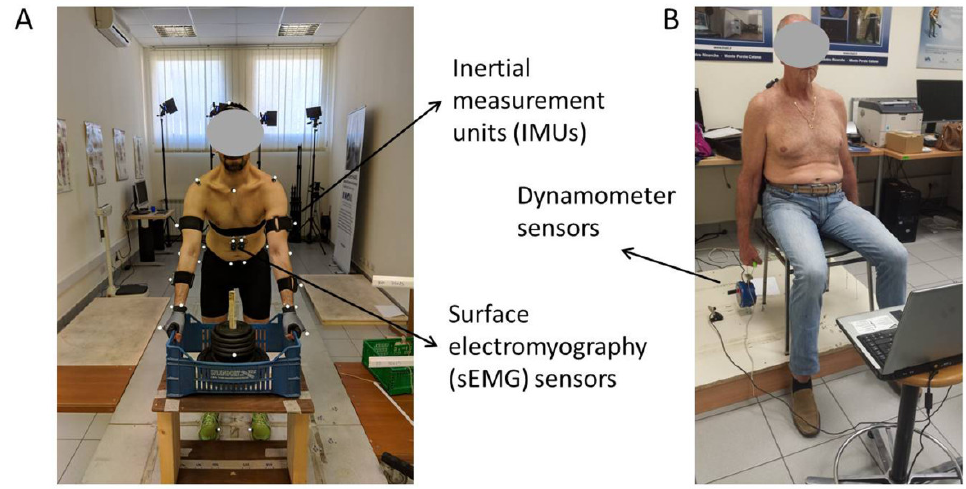
Figure 2. Sensors in ergonomics application: ( A ) Inertial measurement units (IMUs) and electromyography (sEMG) sensors used in lifting acitivities; ( B ) Dynamometer used before and after repetitive work.